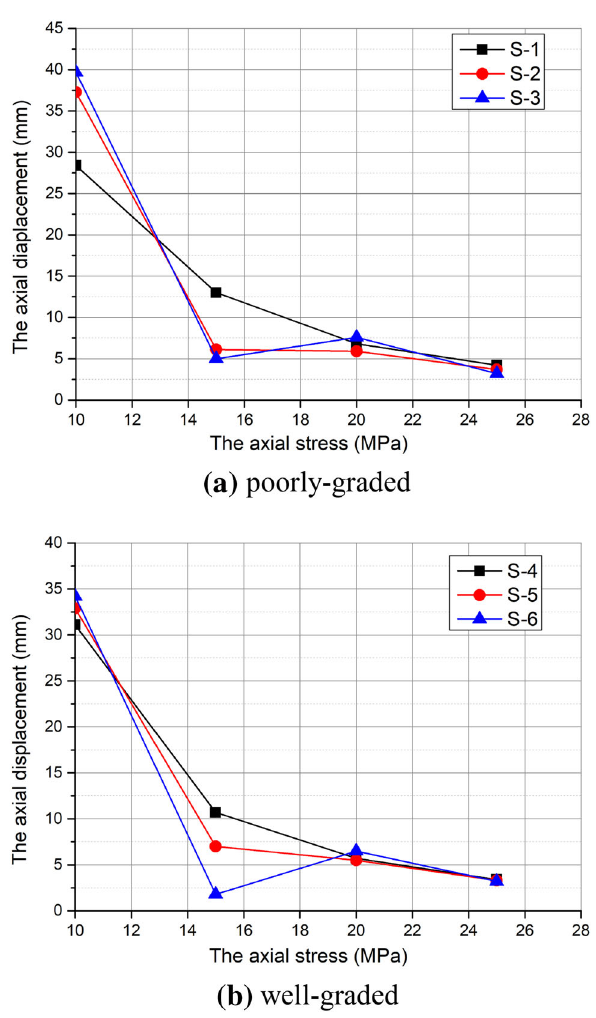
Fig. 7 The axial stress–void ratio curves of crushed mudstones with different grain